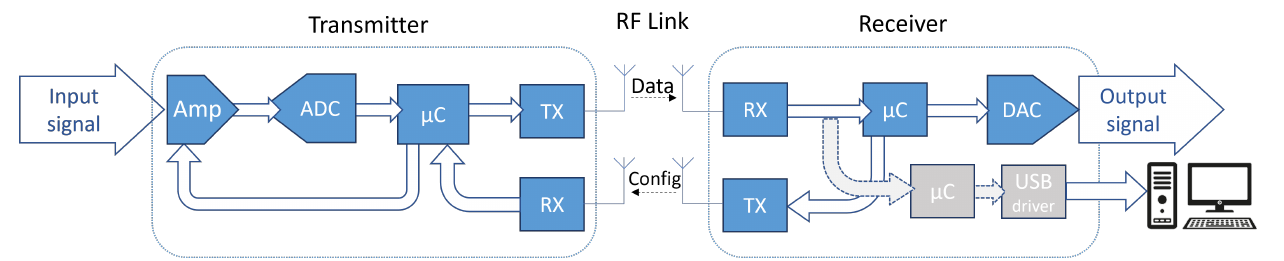
Figure 2. Schematic of the system. The input signal is delivered through standard surface or needle electrodes; the output system is normally the existing IONM setup of the medical facility.